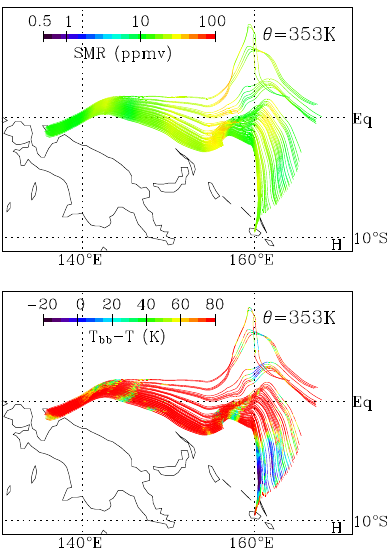
Fig.7. Seven-dayisentropicbackwardtrajectoriesstartedfromBiak(leftend)on353 K surfacecorresponding to the sounding on 8 January 2006. Trajectories are colour-coded by (top) saturation mixing ratio estimated fromECMWFtemperatureanalysisand(bottom)thedifferencebetweentheequivalentblackbodytemperature (brightnesstemperature) T bb observedbygeostationarysatelliteandthetemperature T oftheadvectedairparcel ( δT bb ≡ T bb − T ).